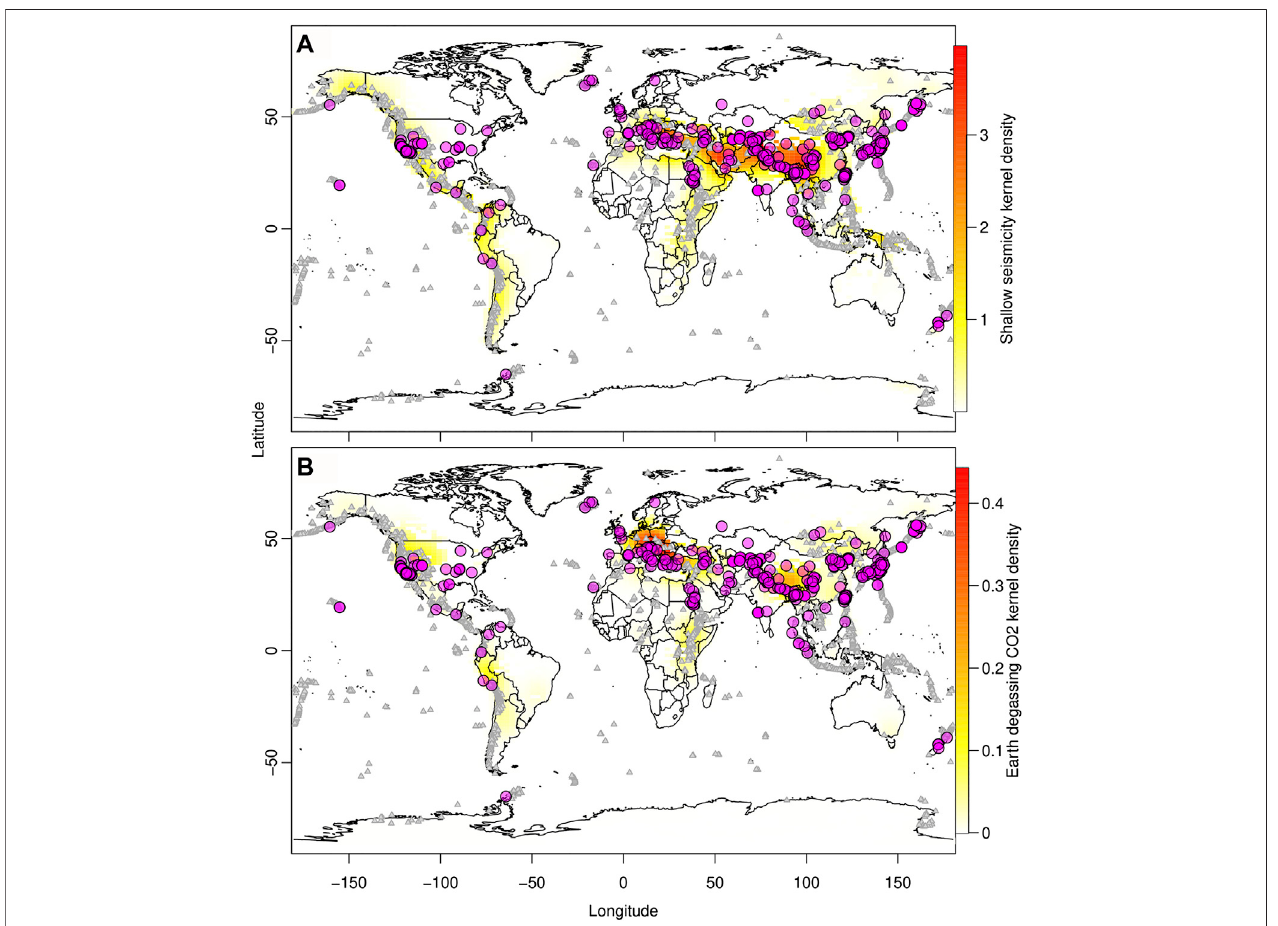
FIGURE 4 | Kernel density maps of (A) shallow (hypocentral depth < 20 km) seismic activity and (B) areas characterized by Earth degassing of CO 2 . Seismic precursors are shown as purple circles and Holocene and Pleistocene volcanoes as small red triangles.